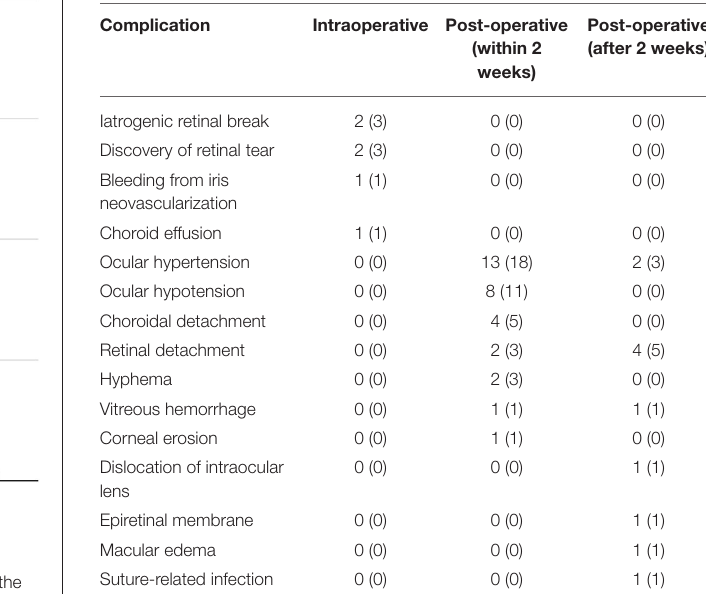
FIGURE 3 | Post-operative change in inflammation scores. cell, cells in the anterior chamber; flare, flare in the anterior chamber; haze, vitreous haze; Pre, pre-operatively; 3M, at 3 months post-operatively. * P < 0.05.